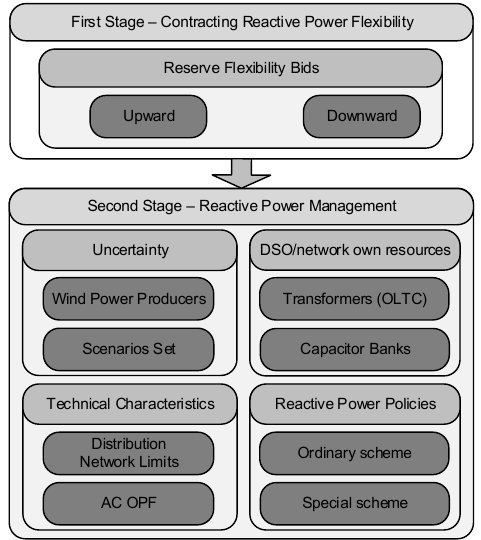
Figure 1. Two-stage optimization model embedded in the sequential AC-optimal power flow (SOPF) tool [15].